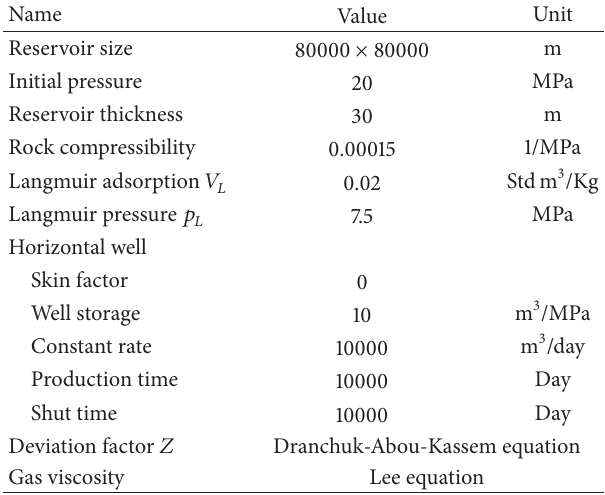
Table 2: Simulation parameters (if not specified additionally).